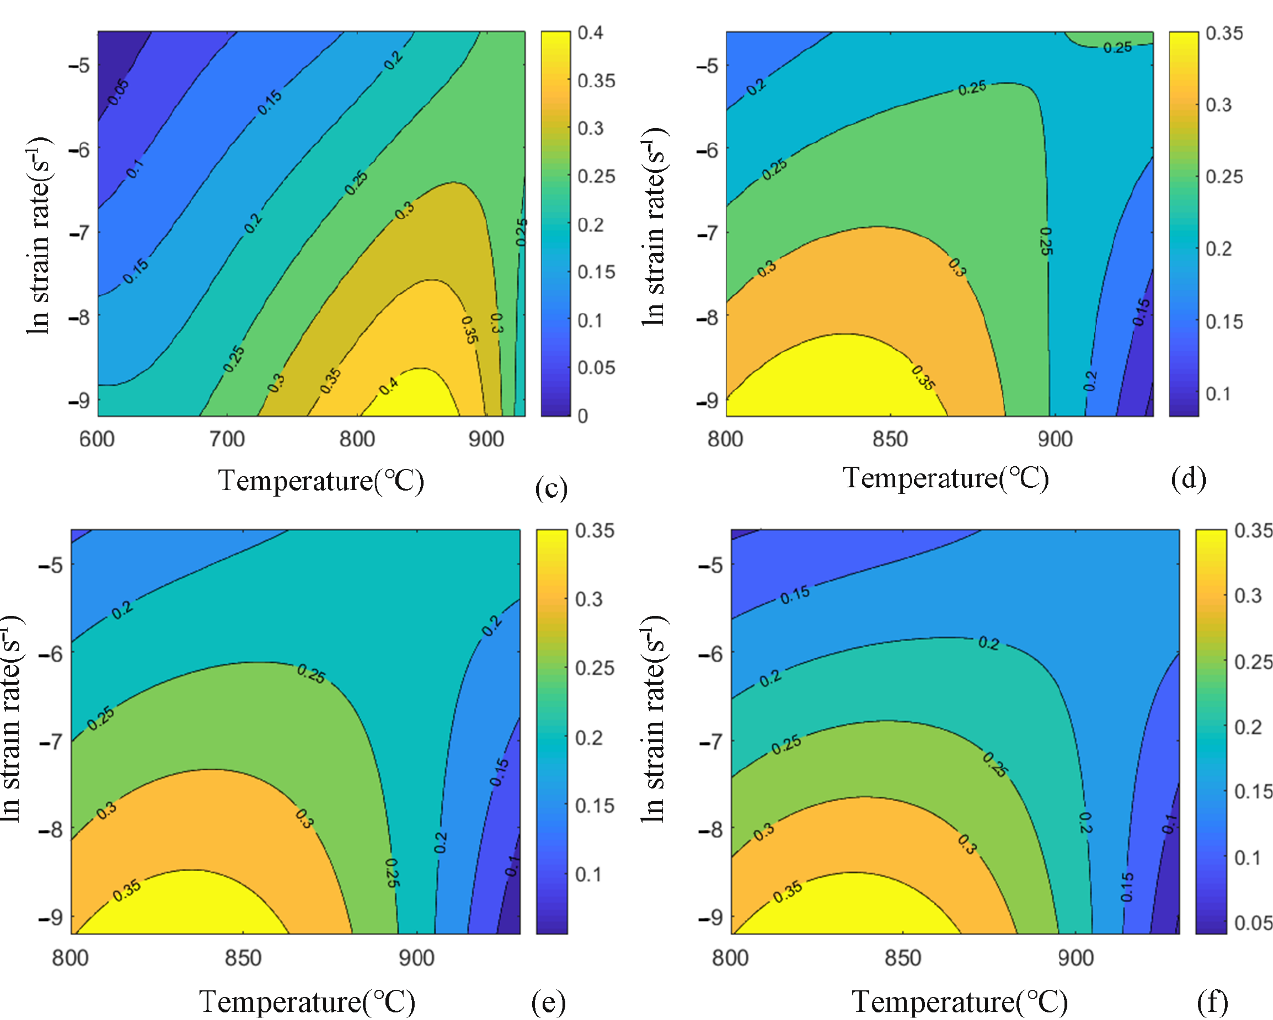
Figure 3. The strain rate sensitivity factors at different strains: ( a ) 0.1; ( b ) 0.2; ( c ) 0.3; ( d ) 0.5; ( e ) 0.6; ( f ) 0.7.